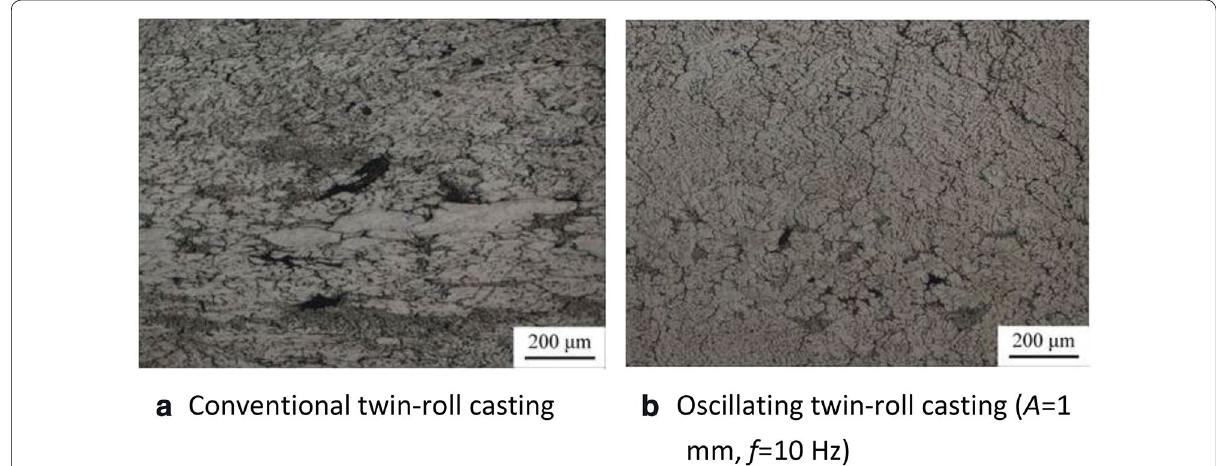
Figure 7 Longitudinal‑section micro‑structure of 3104 aluminum alloys